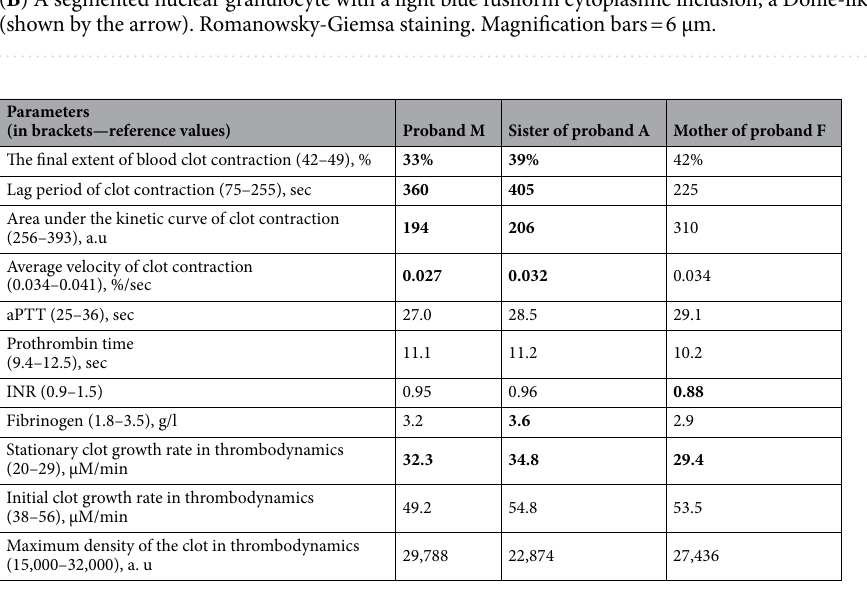
Table 2. The extent of blood clot contraction, hemostasis and thrombodynamics in the patients with a MYH9 gene mutation examined. The numbers in bold are outside the corresponding reference range.